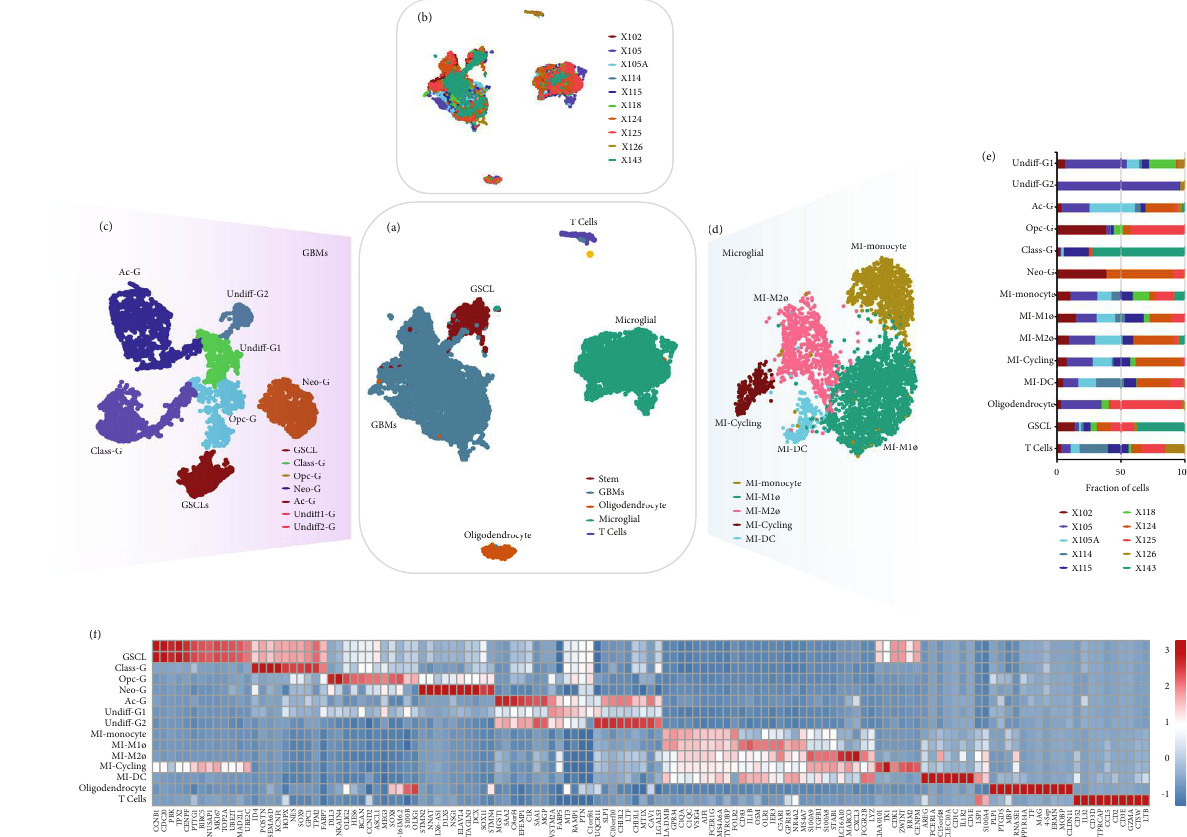
Figure 1: Single-cell atlas of GBM samples. (a) UMAP plot of GBM transcriptomes, color-coded for 5 phenotypes identi fi ed by graph-based clustering. (b) UMAP plot color-coded for each GBM sample. (c) UMAP plot of GBM tumor cell cluster color-coded for 7 phenotypes. (d) UMAP plot of microglial cells color-coded for 5 phenotypes. (e) Reproducible cell subset distributions across samples. Fractions of cells in each cluster derived from all samples are shown. (f) The heatmap of the expression of subset-speci fi c markers across cell